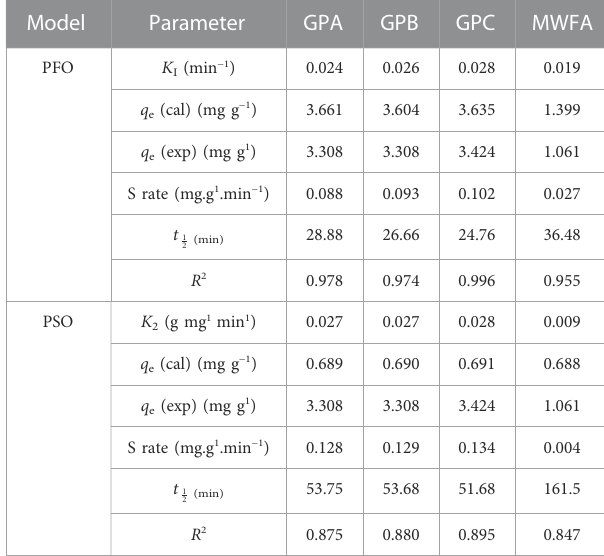
FIGURE 8 Van ’ t Hoff plots.